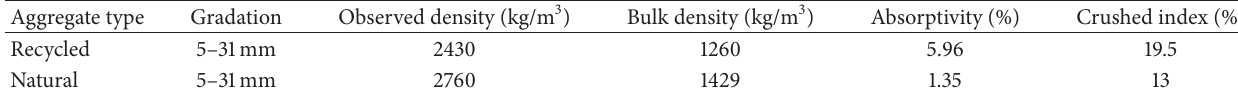
Table 1: Physical properties of coarse aggregates.